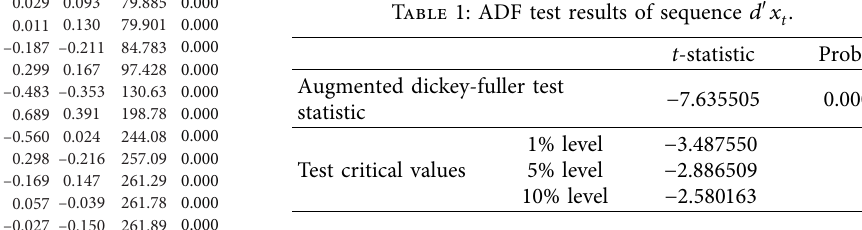
Table 1: ADF test results of sequence d ′ x